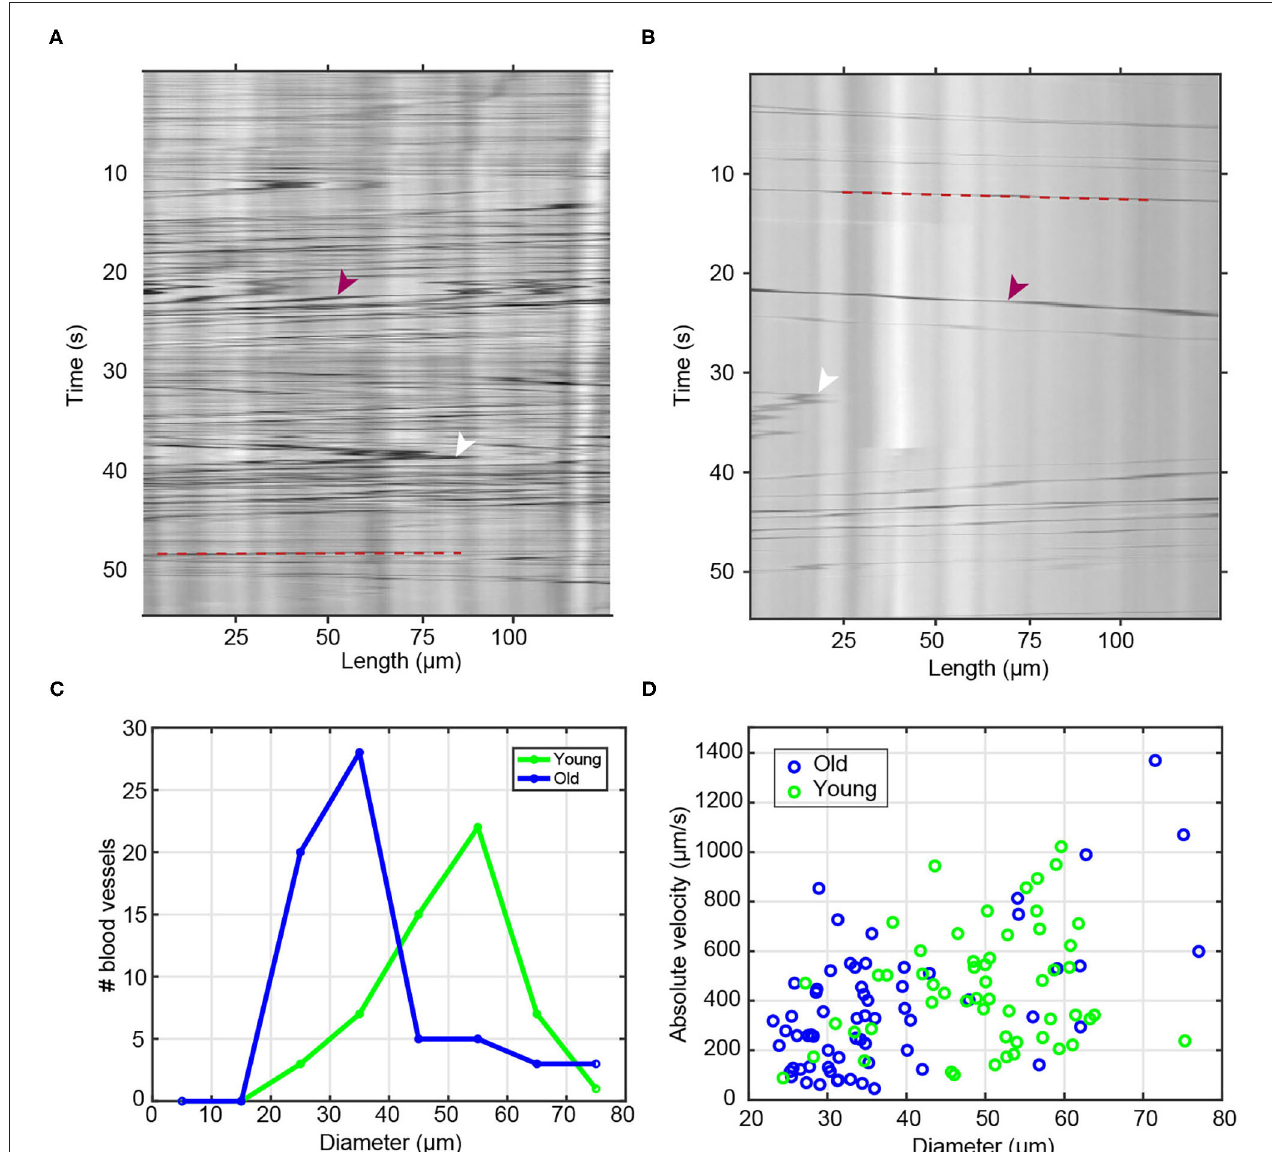
FIGURE 2 | Blood flow and diameter analysis of young and old vessels. (A,B) Raw sample kymographs of blood vessels from (A) young and (B) old animals. Red arrowheads show the high contrast objects/cells and white arrowheads point toward reversals of blood flow direction. Red dashed lines highlight the trajectory of a blood cell. (C) Histogram of measured blood vessel diameter in young ( n = 55) and old ( n = 64) animals. (D) Scatter plot of measured maximum flow velocity as a function of blood vessel